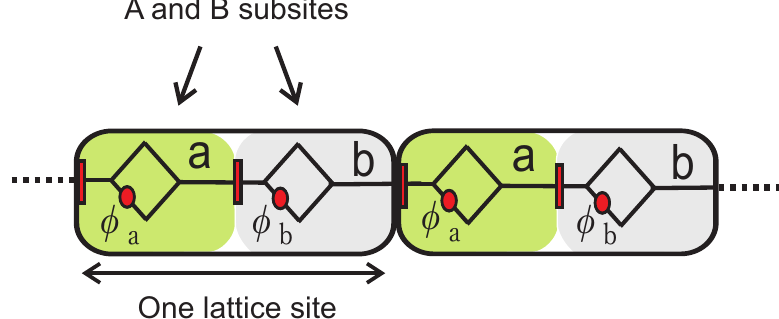
Figure 9. Diamond graphs, made from two directionally unbiased three-ports, as shown in Figure 8; each cell (indicated by the dashed curves) is made from four three-ports. The two diamond graphs at each site may have different internal phase shifts, φ a and φ b . The red rectangles are phase plates that rotate the polarization by 90 ◦ , so photons in the right half of the cell have vertical polarization (state b), while those in the left half have horizontal polarization (state a). The size of the diamond graphs is exaggerated for clarity—they should be small compared to the distance separating